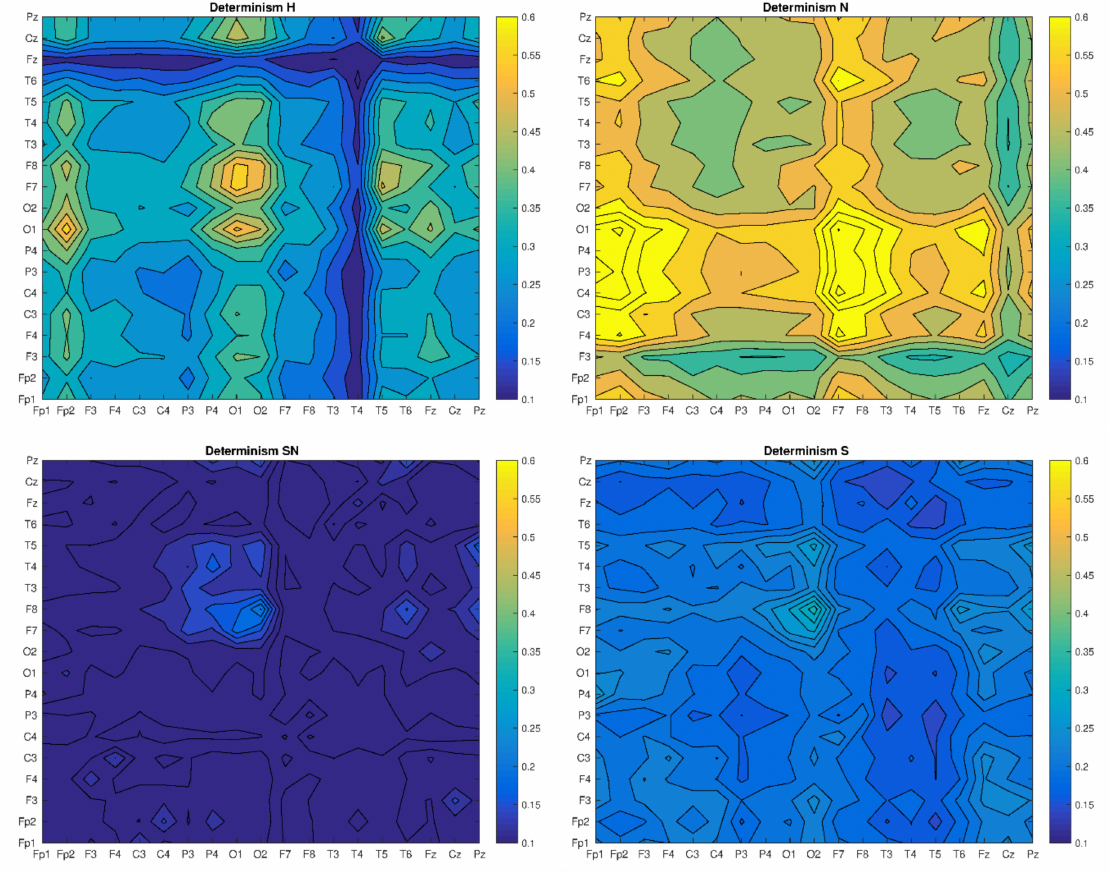
Figure 4. The Determinism matrix of four trails for all bands: H, N, SN and S,